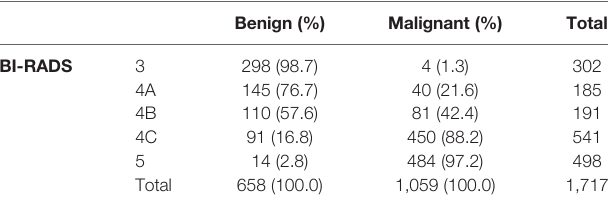
TABLE 4 | BI-RADS classi fi cation information for eligible patients after